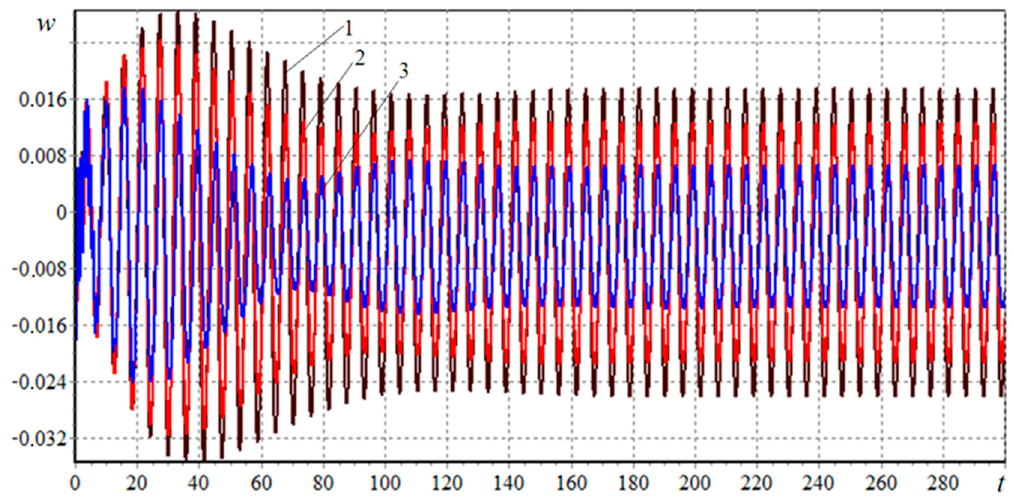
Figure 6. Dependence of the deflection on time at (1) α * = 0.2, (2) α * = 0.5, and (3) α * = 0.8